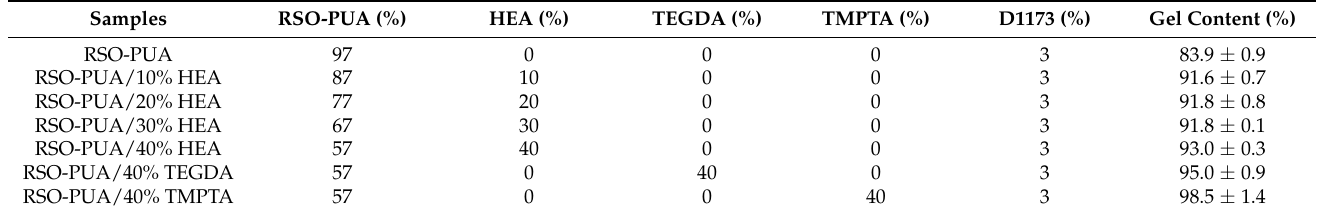
Table 1. Composition and gel content for the UV-curable RSO-PUA samples.